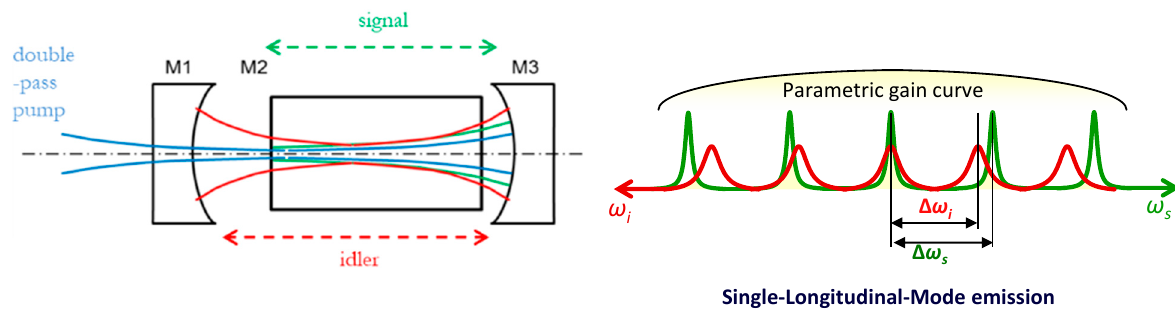
Figure 4. NesCOPO doubly resonant configuration and principle of operation for single-frequency emission (signal and idler cavity lengths differ by a few percent, allowing only a single pair of signal and idler cavity modes to overlap and respect the energy conservation relation ( ω p = ω s + ω i )).